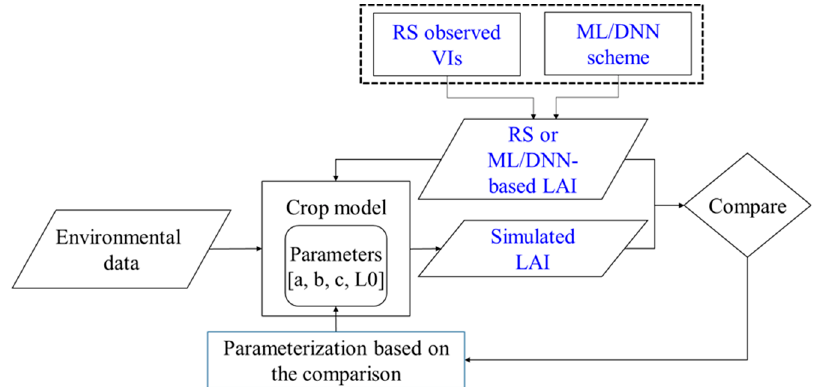
Figure 1. Schematic diagram of the process-based mathematical crop model integrated with RS- observed vegetation indices (VIs) or machine learning (ML) and DNN schemes to simulate LAI and yield. A statistical comparison between the RS or ML/DNN-based LAI and the simulated LAI values is achieved. The dotted line box represents the optional input procedure of the mathematical regression for the ML or DNN regressor to the estimated LAI. The environmental data include incident solar radiation and minimum and maximum atmospheric temperatures.